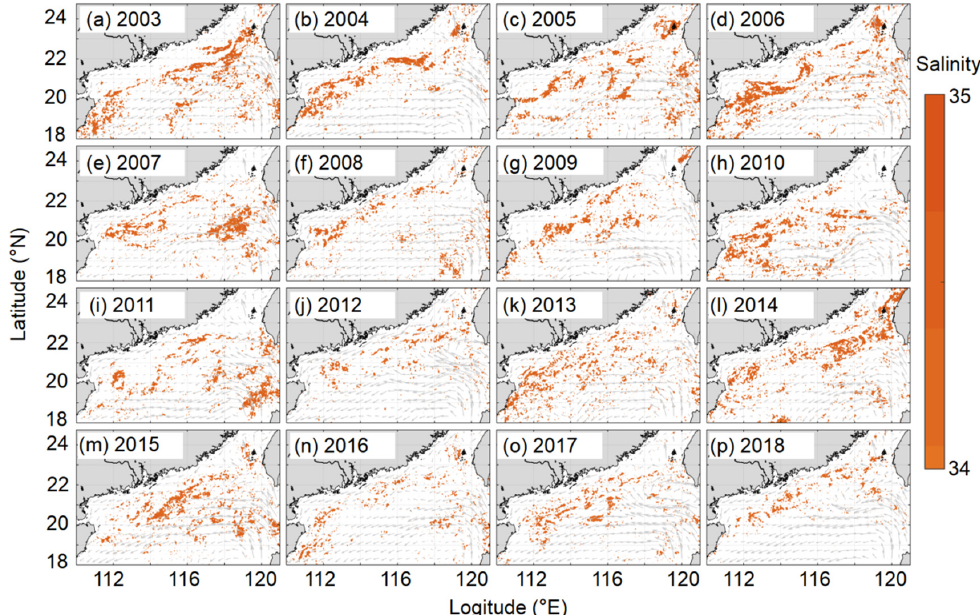
Figure 13. Spatial distribution of relatively high sea surface salinity (SSS ≥ 34.25) and sea surface circulation in the winter in the northern South China Sea from 2003 to 2018. The SSS represents our reconstructed data; surface circulation data are from https://resources.marine.copernicus.eu/ (accessed on 30 August 2021).